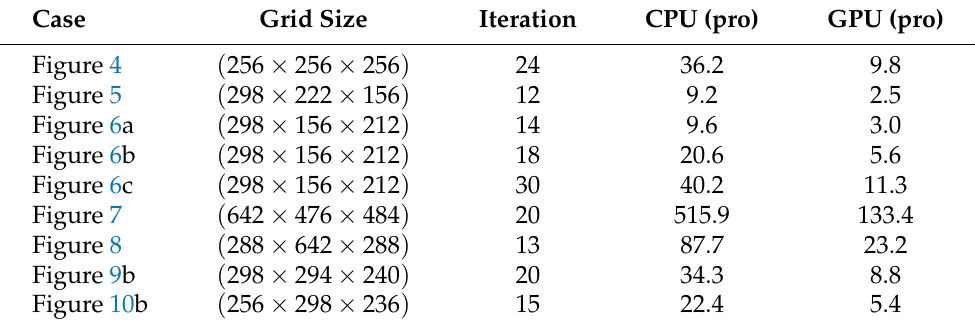
Table 1. List of grid size, iterations, CPU times (second), GPU times (second), and errors. CPU(pro) and GPU(pro) are the times taken to process the multi-reconstruction by using the computer’s central processing unit and graphics processing unit, respectively.